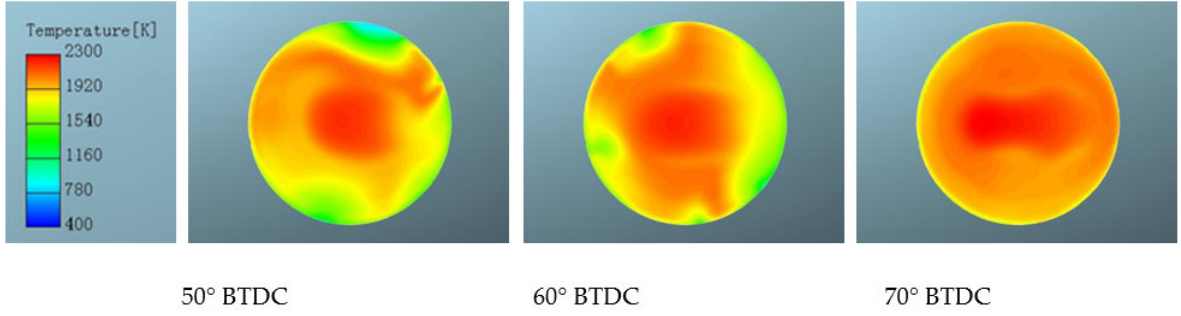
Figure 12. Temperature field distributions corresponding to different injection end angles.